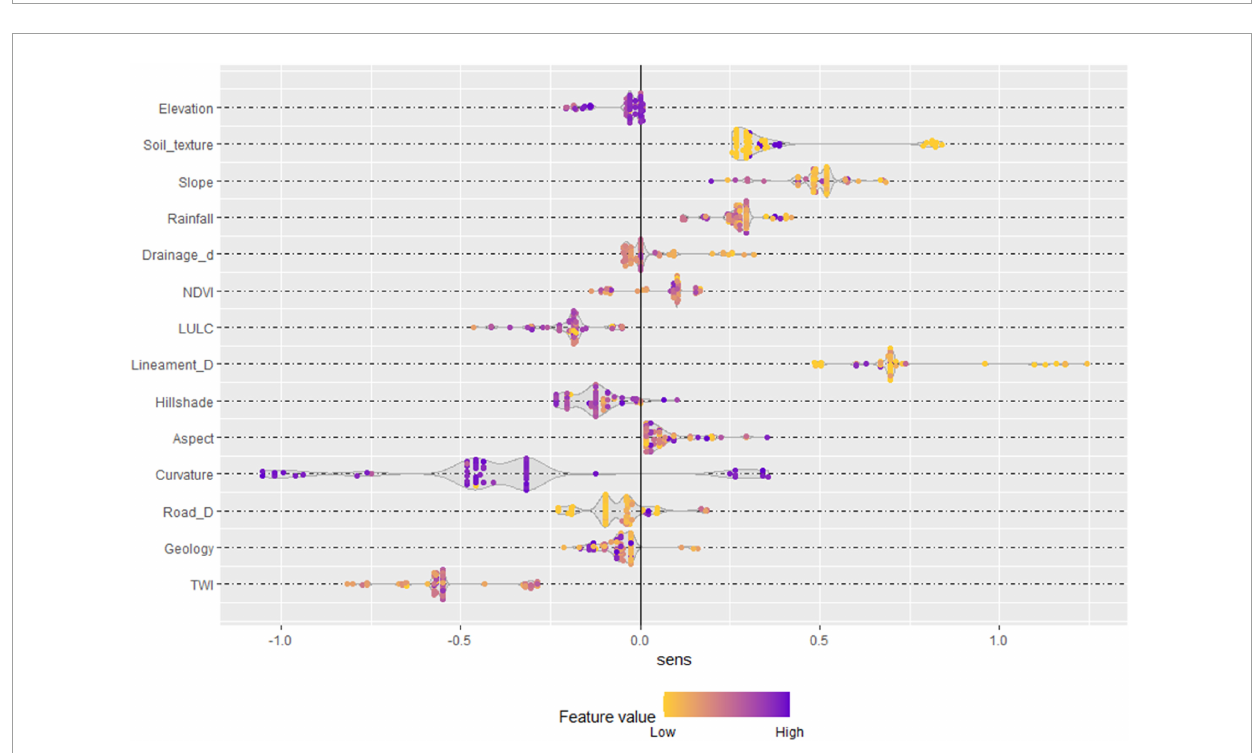
FIGURE15 The influence of value of each sample of input parameters to the LSM.